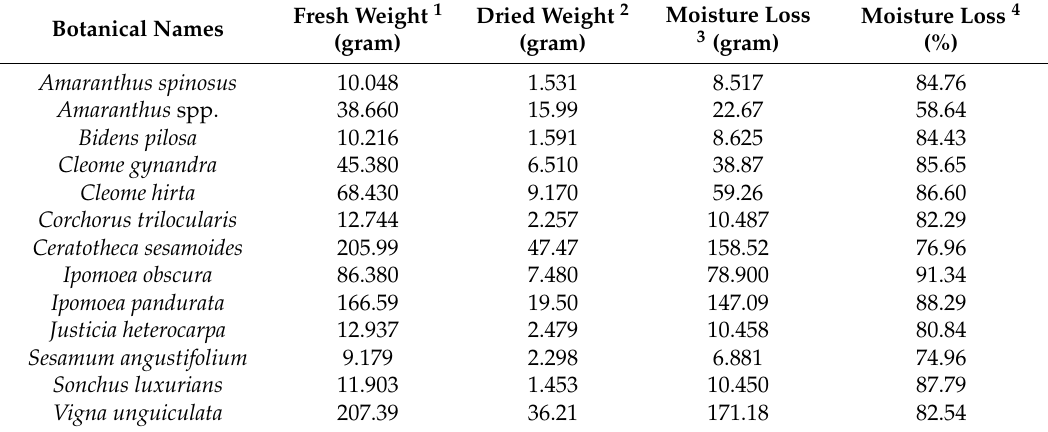
Table A1. Weights of ILVs before and after freeze drying in grams